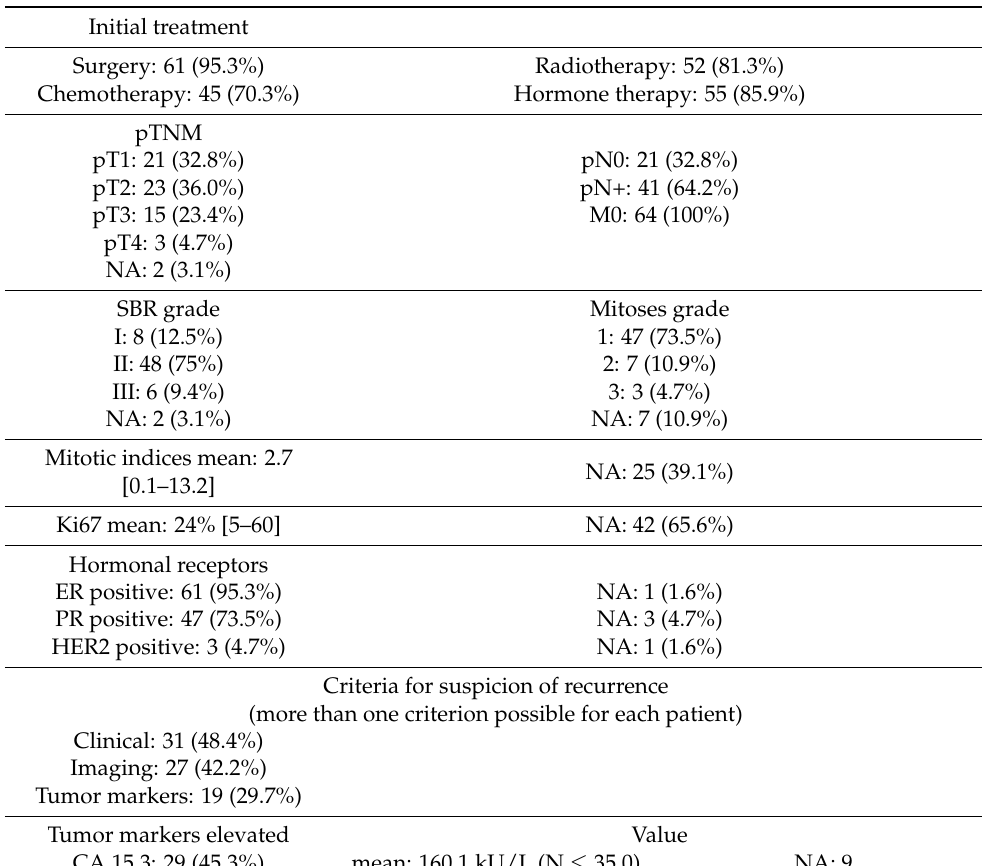
Table 1. Characteristics of the study population.